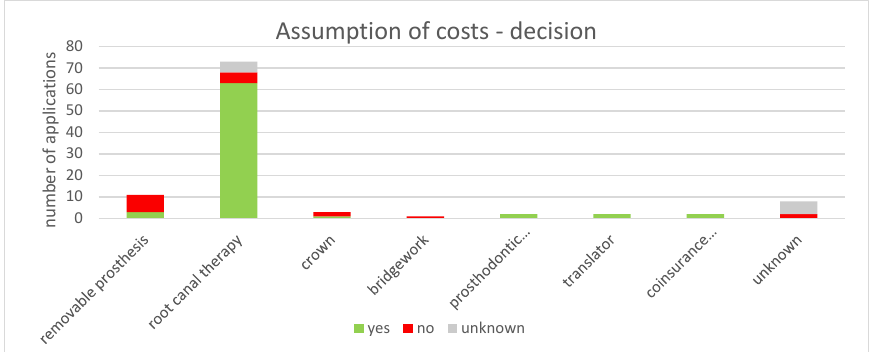
Figure 3. Decisions by the social welfare office to cover the cost of dental treatment applications. The majority of claims concerns root canal therapy and most of them were approved.